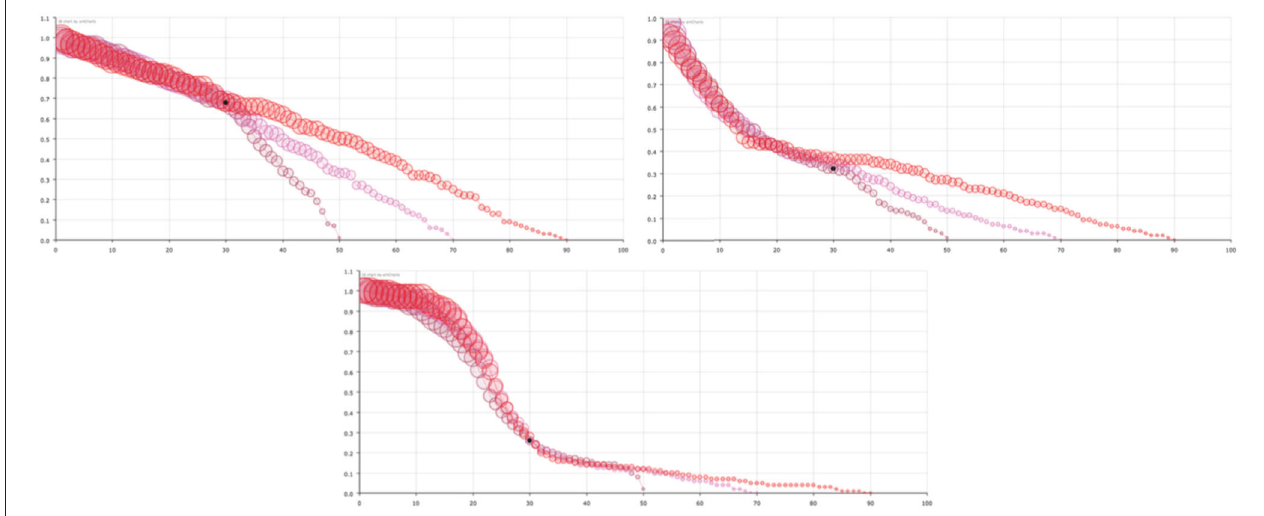
FIGURE 5 | Survival curve of the virus considering different number of days for USA (left-top) , Spain (right-top) , and South Korea (center-bottom) . Red circles corresponds to data of the first 90 days, pink circles to only the first 70 days and maroon circles to only the first 50 days. The size of the balls is proportional to their value at the point.